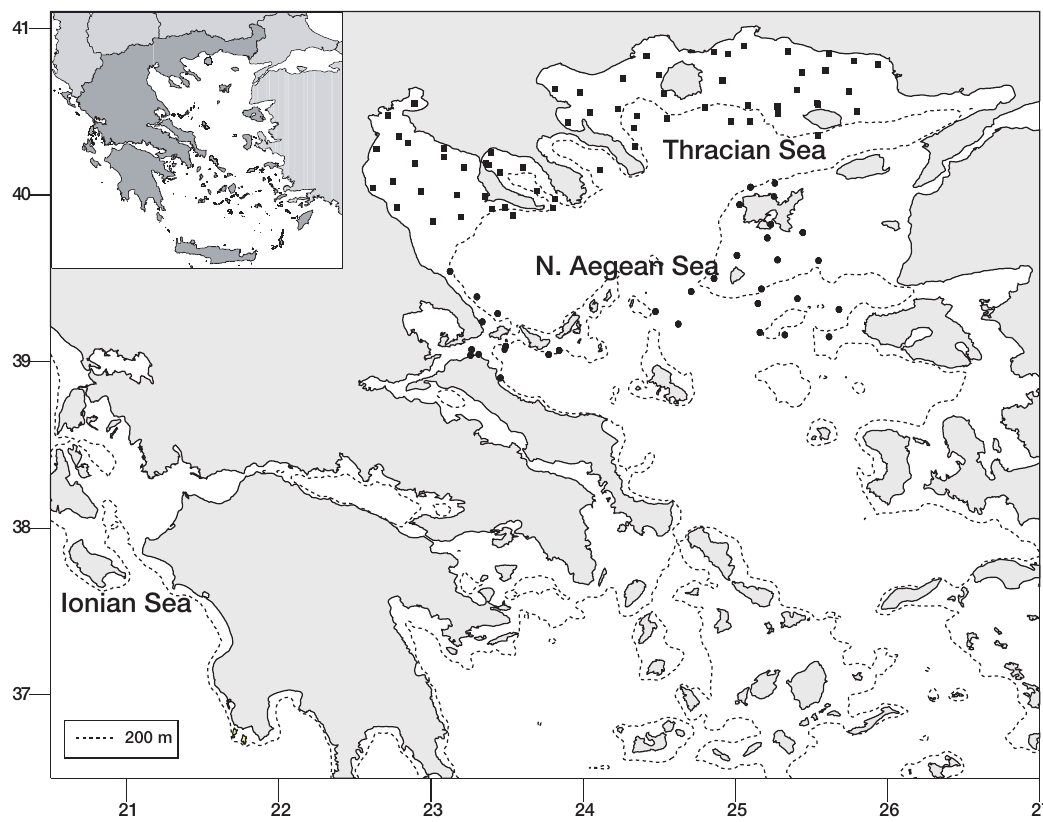
Fig. 1 . – Sampling stations on the continental shelf and the upper slope of the study area. Full squares, Thracian sea; full circles, Northern Aegean